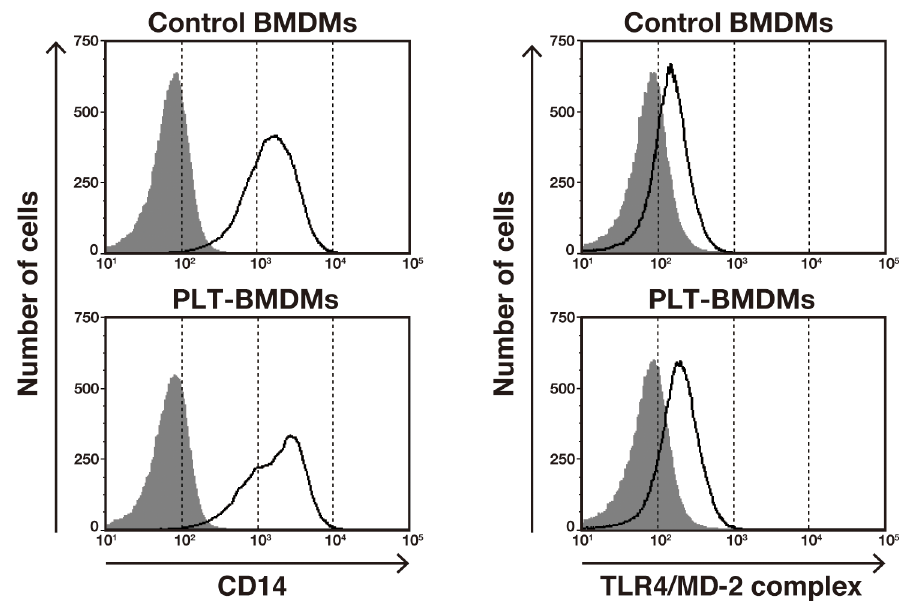
Fig 2. Cell surface expression of CD14 and the TLR4/MD-2 complex in PLT-BMDMs. PLT-BMDMs and control BMDMs were incubated with anti-mouse CD16/32 at 4°C for 10 min, and then incubated with biotin anti-mouse CD14 antibody or rat anti-mouse TLR4/MD-2 complex antibody at 4°C for 30 min. After incubation with streptavidin-PE or anti-rat IgG-Alexa Fluor 647 antibody at 4°C for 30 min, cells were analyzed by FACSVerse (BD Biosciences). The data are shown as histograms representing the number of cells (Y-axis) against the log of fluorescence intensity (X-axis). The black lines represent cells with primary antibody, and the gray-shaded areas represent cells without primary antibody. Experiments were repeated three times, and representative results are shown.